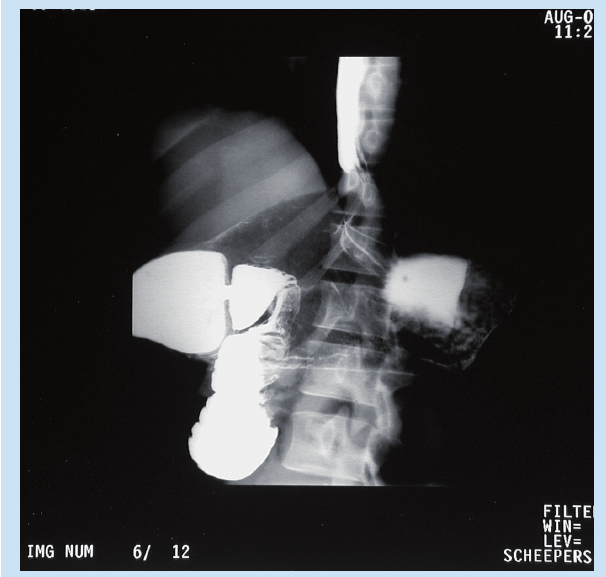
Waldeyer.Fig. 2. Barium meal showing dilated stomach with normal-appearing antrum and duodenal cap. The descending part of the duodenum is